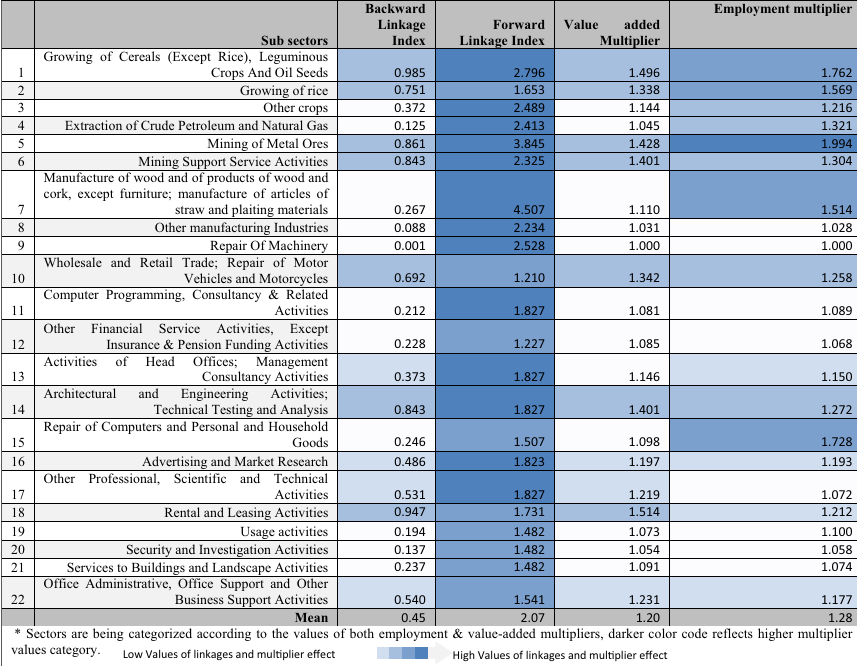
Figure 3. Sectors with strong forward